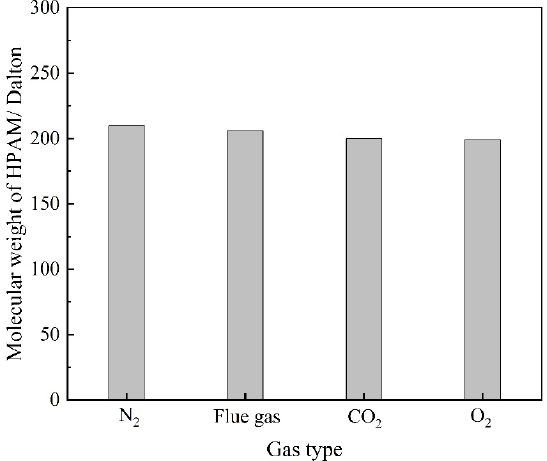
Figure 7. The changes in the molecular weight of HPAM treatment with different